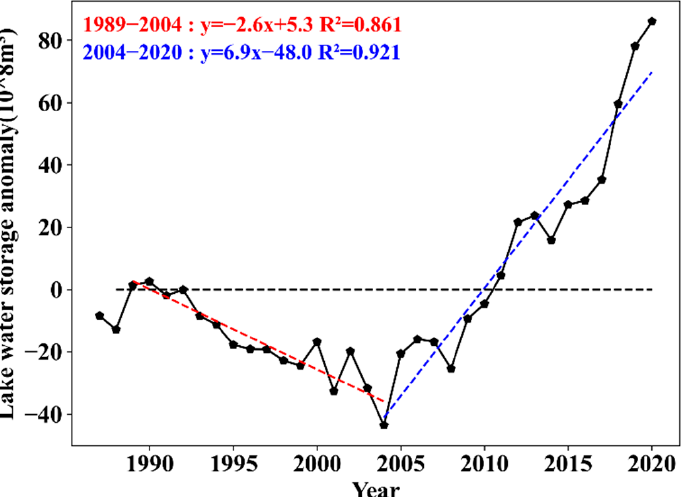
Figure 4. The time series change of the QHL storage anomaly from 1987 to 2020.